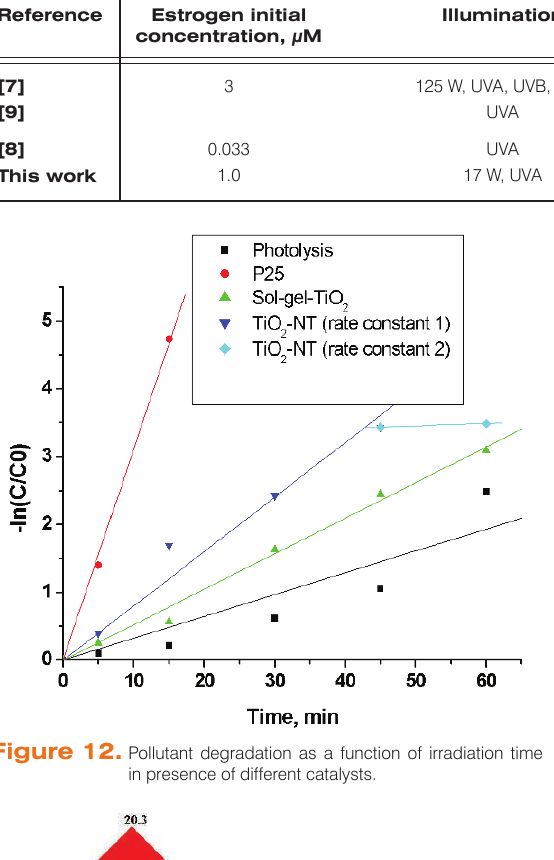
Table 6. Effectiveness of some methods for photocatalytic degradation of EE2.